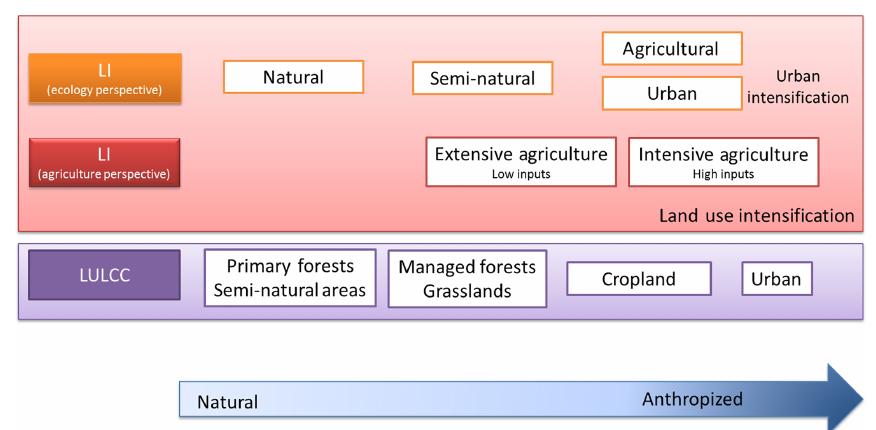
Figure 3. Main changes in LULCC and LI (land use intensification) from an anthropic perspective and their classification relative to the sections of this